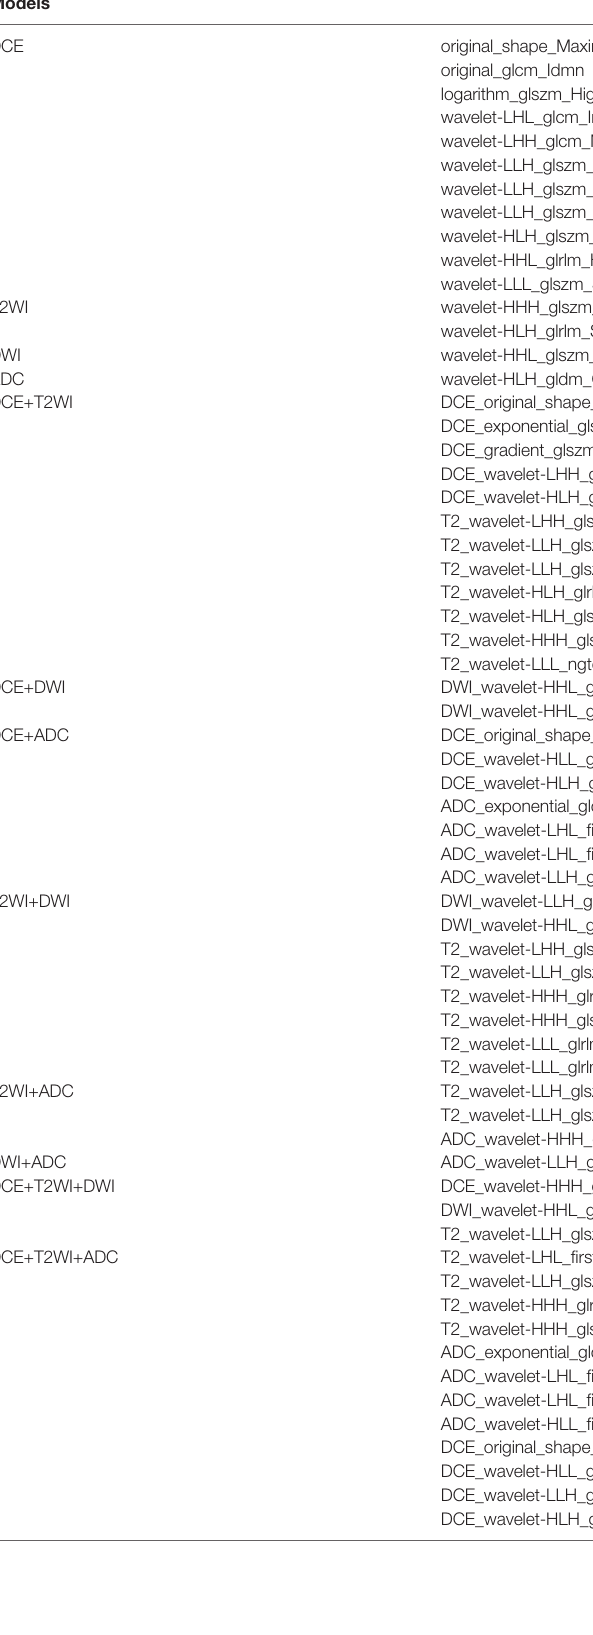
TABLE 2 | Radiomic features of the single-layered and fusion radiomic models.